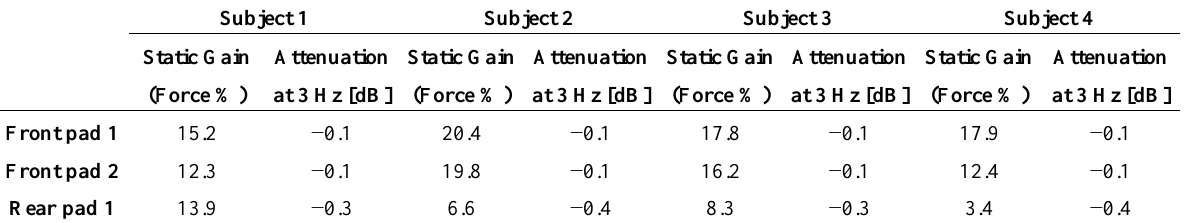
Table 4. Fraction of the interaction force unloaded on each pad, and preloading force acting on each sensor, for the four subjects during the dynamical